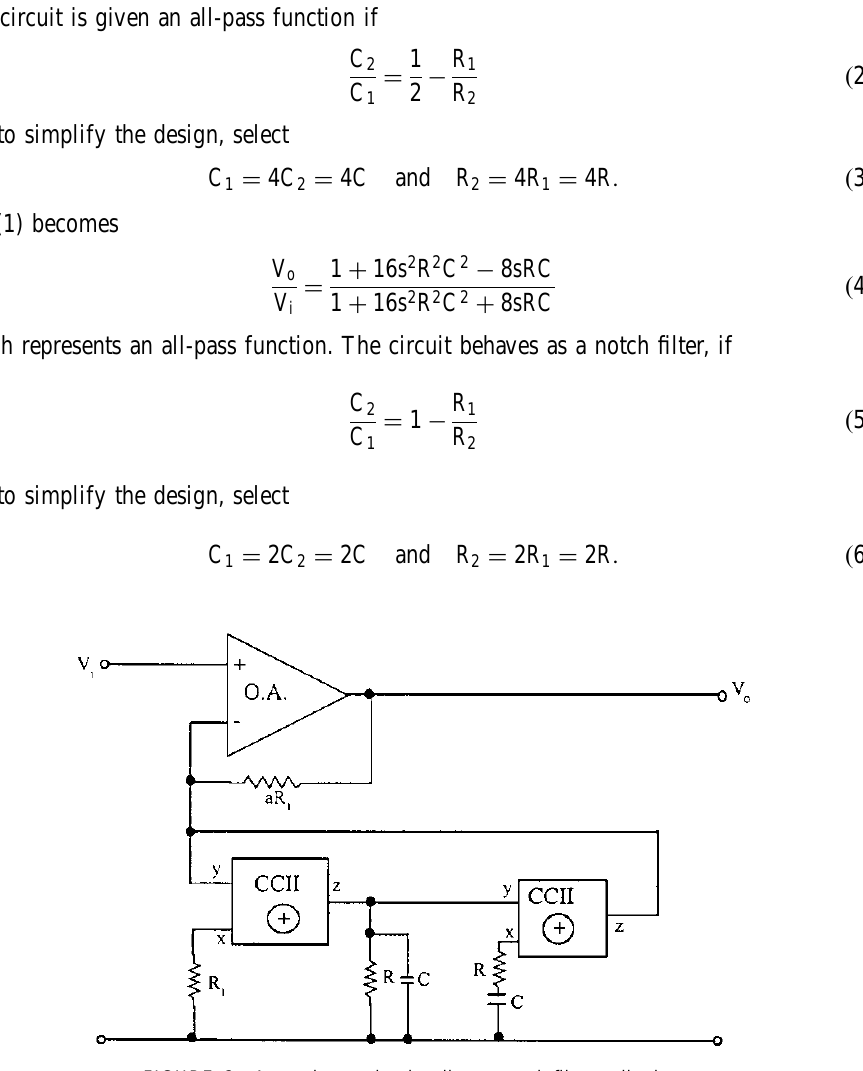
FIGURE 2 A novel second-order all-pass = notch filter